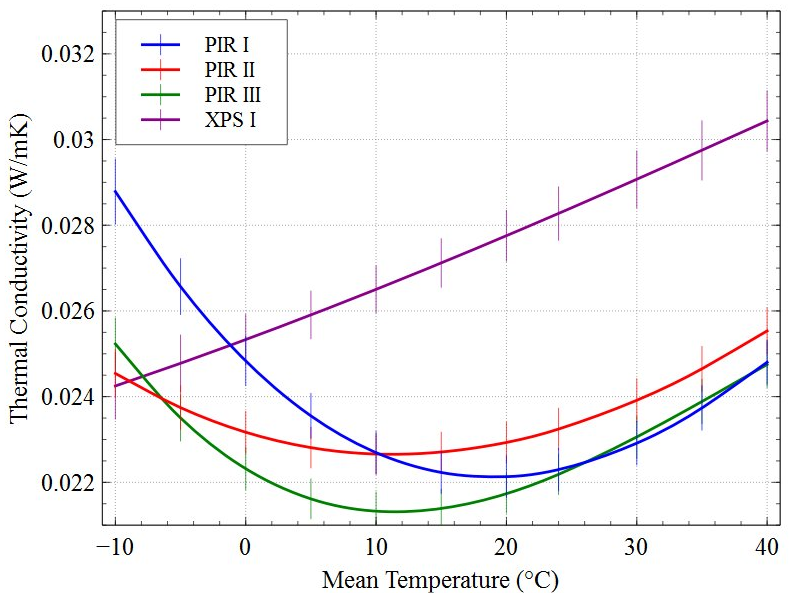
Figure 3. Thermal conductivity as a function of mean temperature for specimens initially measured within 2 weeks of